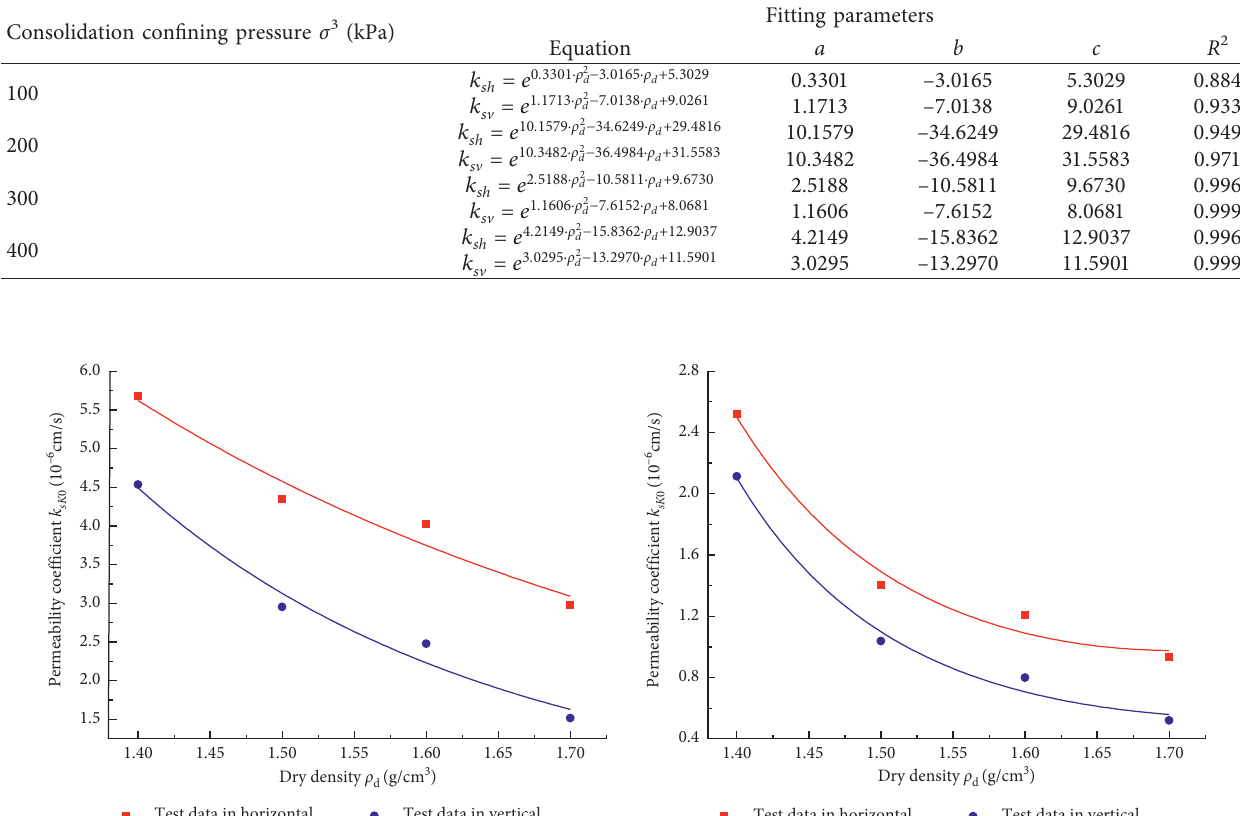
0 consolidation.